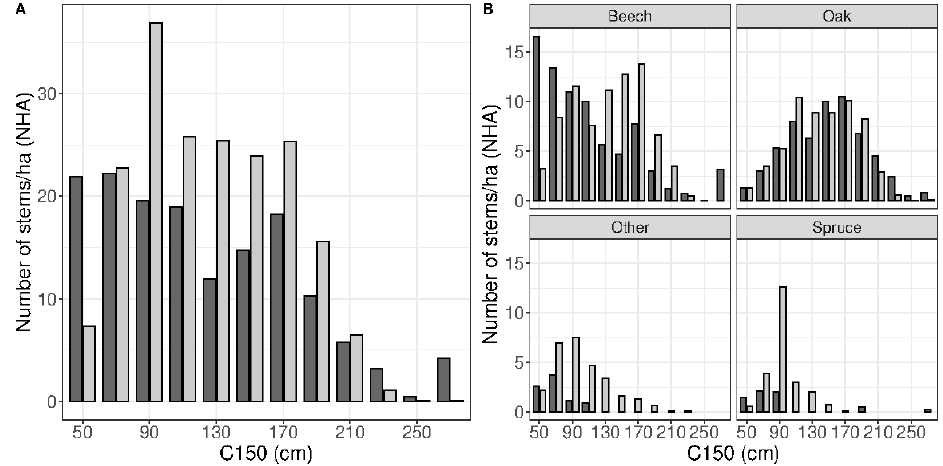
Figure 10. SSDs for the independent dataset: ( A ) total SSDs per hectare (all species) and ( B ) species- specific SSDs per hectare. Dark bars correspond to field measurements and light bars to predictions. Table 8. Species-specific SSD accuracies computed by species class for the independent dataset. Species Proportion of Basal Area (%) in the Independent Dataset